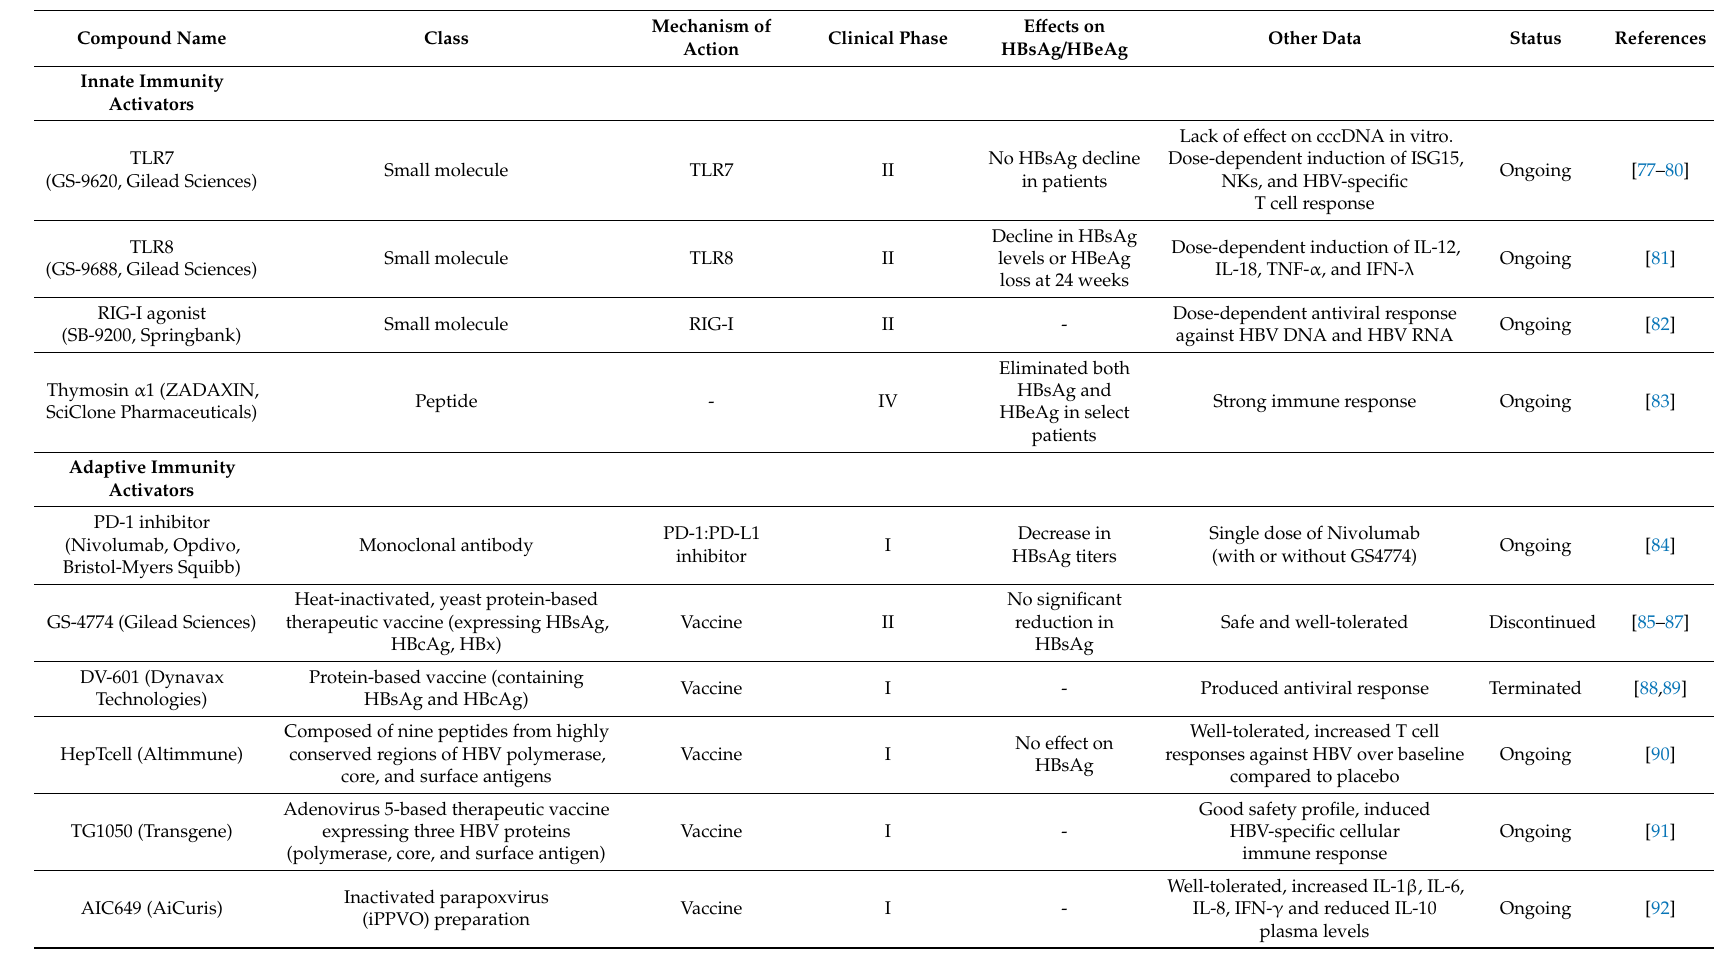
Table 1. Summary of immunomodulatory agents in clinical trials targeting